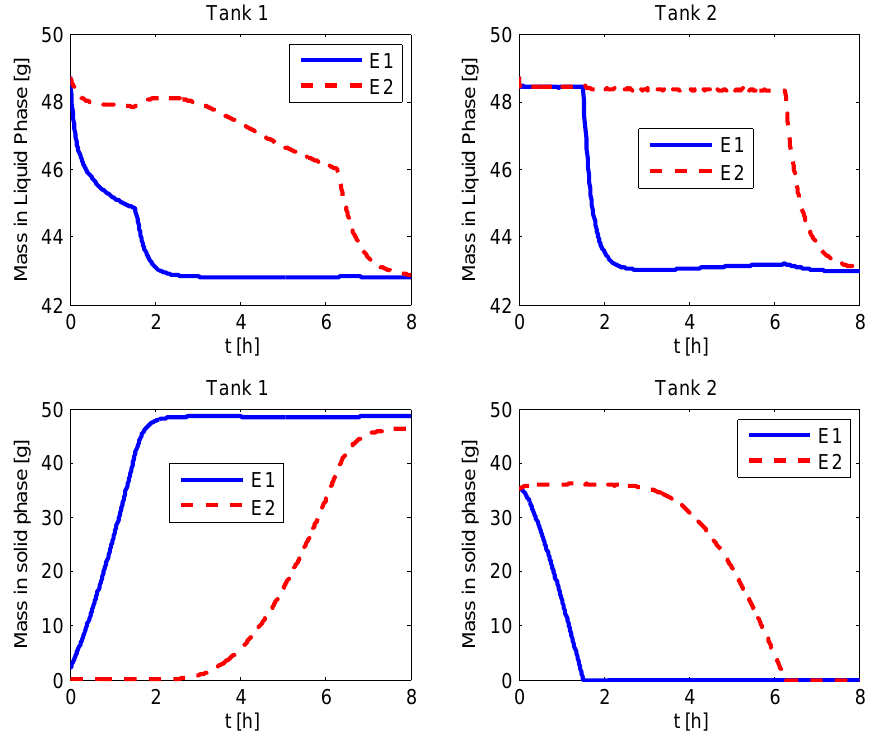
Figure 4. Evolution of mass in liquid and solid phases for the coupled preferential crystallization-dissolution (CPC-D)